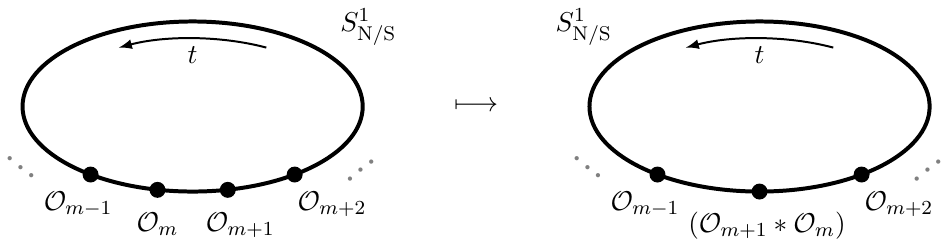
Figure 3 . In a topological correlator, two adjacent insertions can be replaced by a single one corresponding to their star